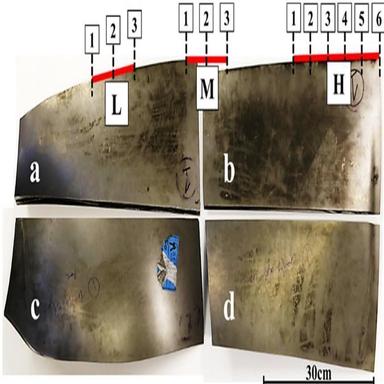
As received ex-service turbofan blade.